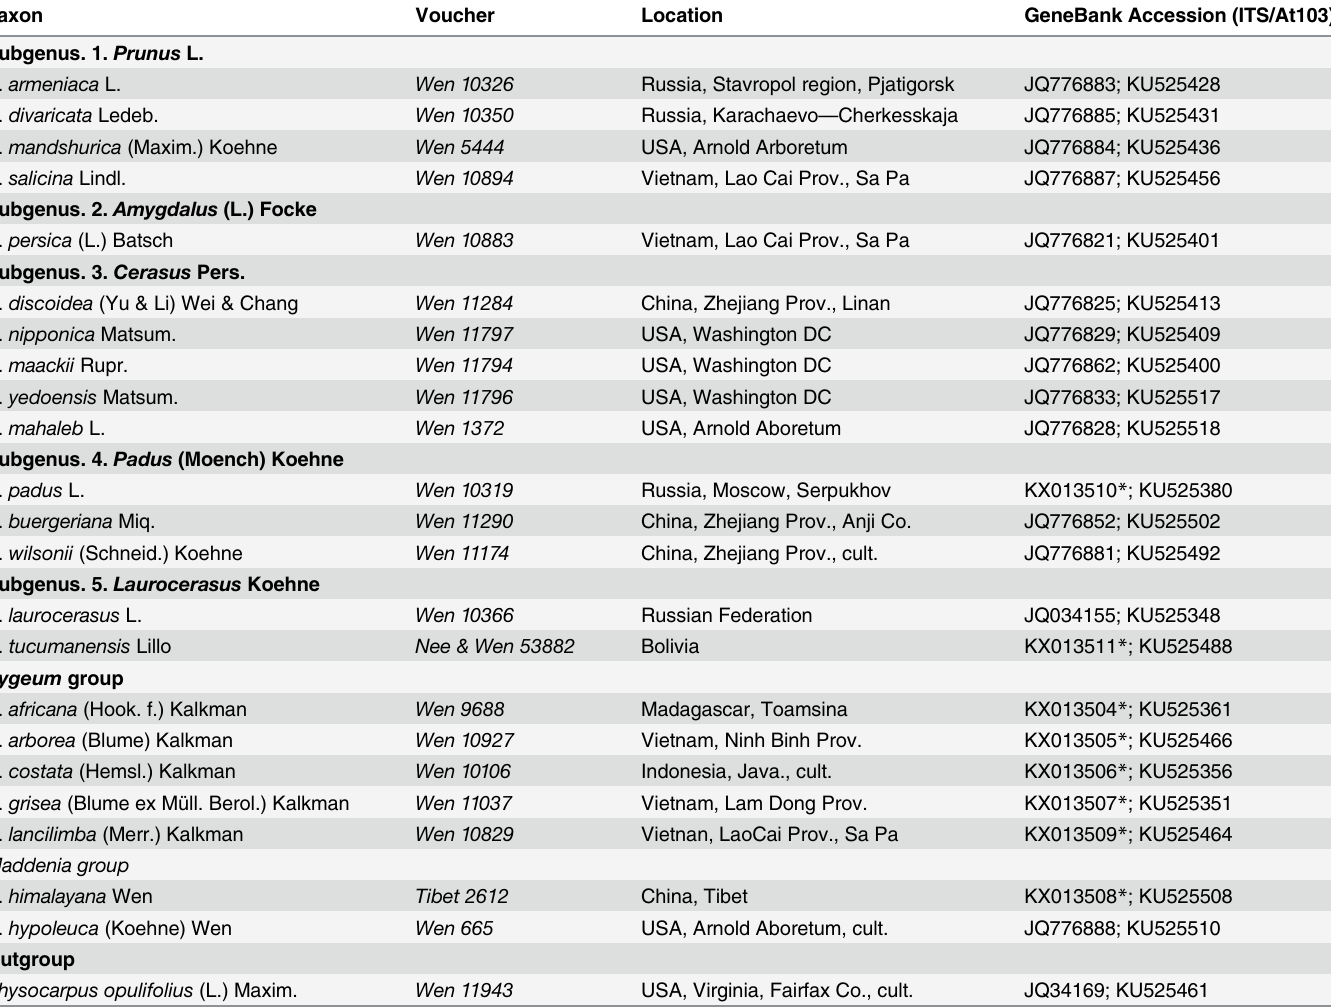
Table 3. Taxa and At103 and ITS GenBank accession numbers of Prunus and outgroups sampled for this study. All voucher specimens are depos- ited in the US National Herbarium (US). Newly generated sequences are indicated by an asterisk ( * ).